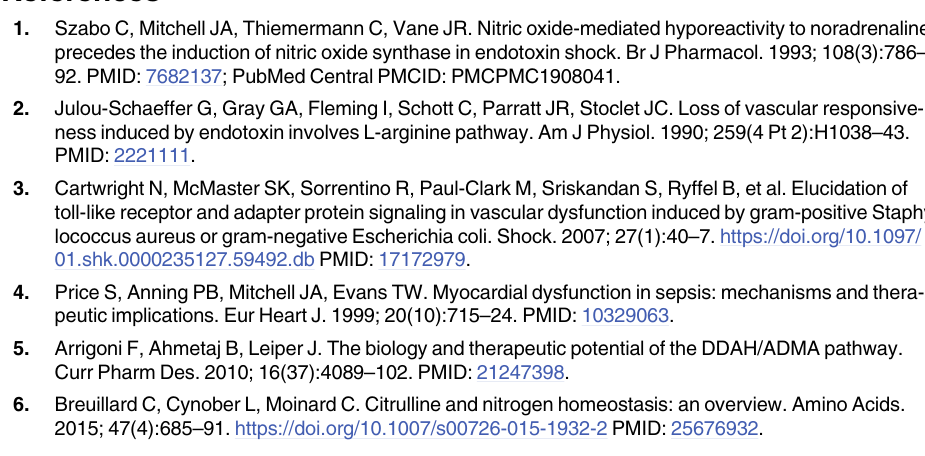
S1 Table. List of amines measured in human plasma using UHPLC-MS/MS, LC-MS/MS and/or ELISA. Data are mean ± SEM for n = 21 healthy donors and n = 38 patients with sep- sis. Data was analysed by either one-way ANOVA with Dunnett’s post-hoc test or, where appropriate, Kruskal-Wallis one-way ANOVA with Dunn’s post-hoc test. (cid:3) p < 0.05 when com- pared to healthy